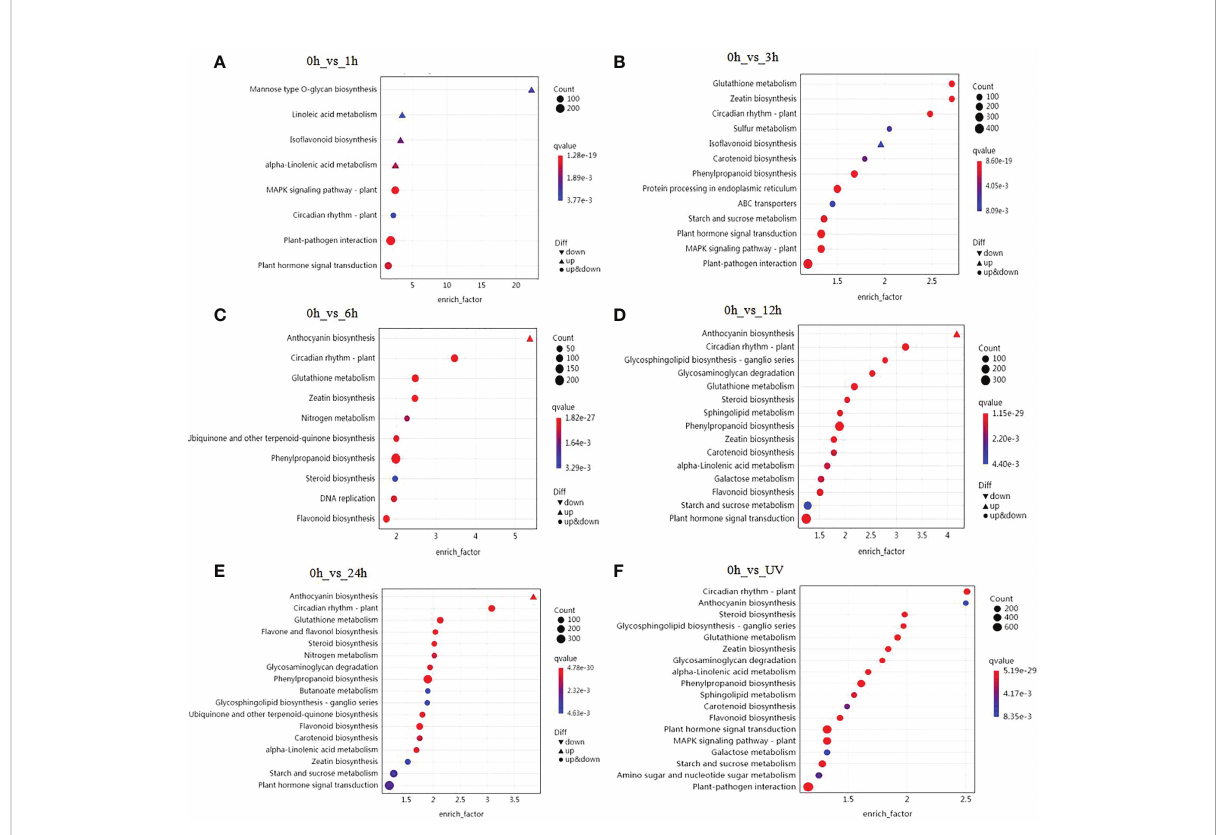
FIGURE 2 Summary of KEGG pathway enrichment analysis. Analysis of signi fi cantly enriched DEGs after 1 h (A) , 3 h (B) , 6 h (C) , 12 h (D) , or 24 h (E) of UV- B radiation compared to 0 h The number of DEGs is indicated by the size of the circle, and the solid upper triangle and inverted triangle represent upregulated and downregulated DEGs, respectively. (F) Analysis of signi fi cantly enriched DEGs comparing the control samples (0 h) to all samples exposed to